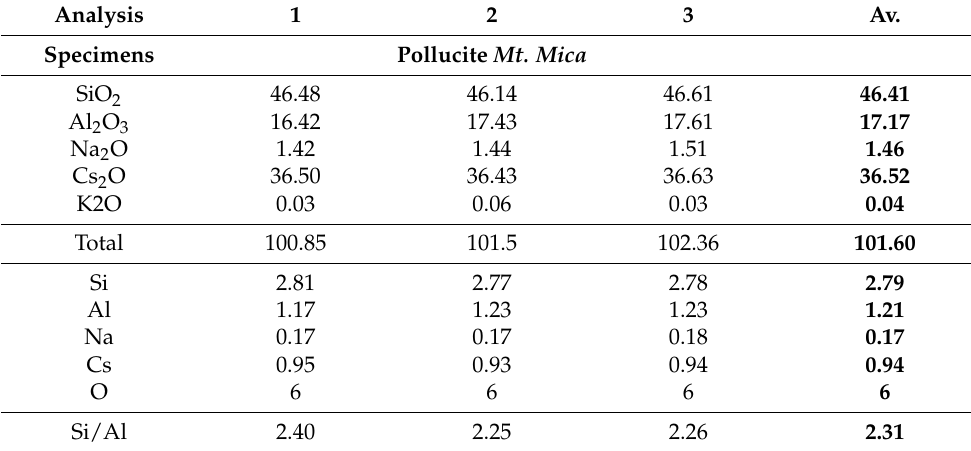
Figure 2. BSE image of a veinlet in pollucite of specimen Tanco showing the points were the specific EMPA analysis were obtained, shown in Table 1. Analysis nº 1 to 5 correspond with pollucite (clear contrast) and nº 6 to 9 with hydrated unidentified minerals (dark contrast). Table 2. Chemical compositions by EMPA of specimen Mt. Mica .